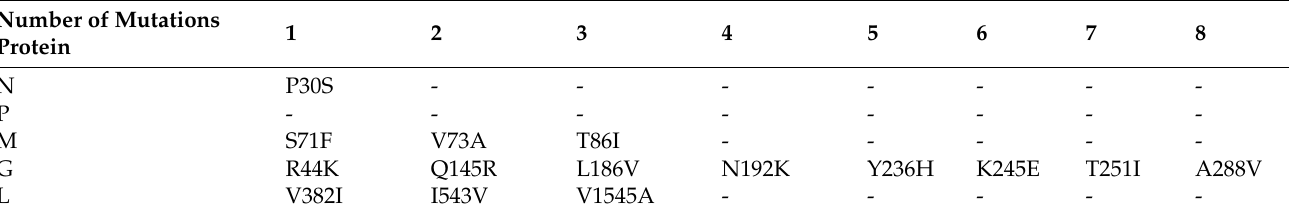
Table 2. Overview of amino acid substitutions present only in BoDV-1 “Dessau”, but not in other